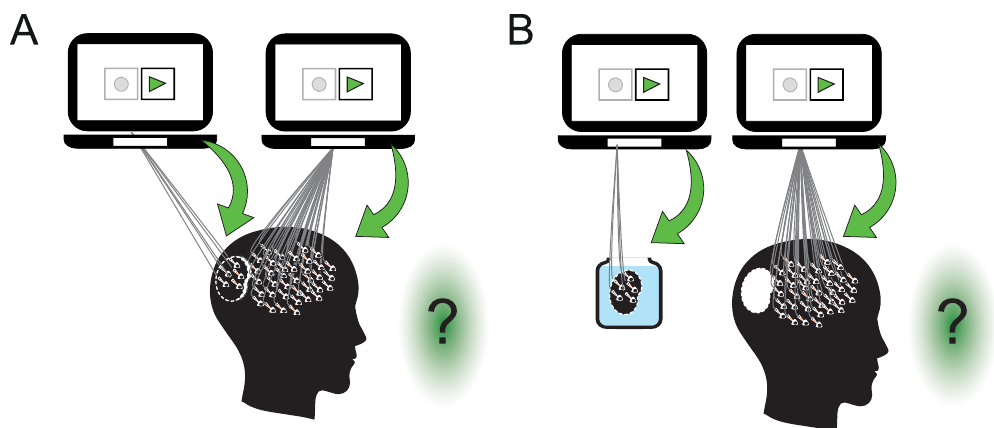
Fig 3. Step 3: Surgically removing brain tissue. (A, B) The visual cortex is resected and then the action potentials are played back, respectively, to the removed visual cortex and the rest of the intact brain. We can either leave the resected visual cortex in its place (A) or remove it from the participant’s brain